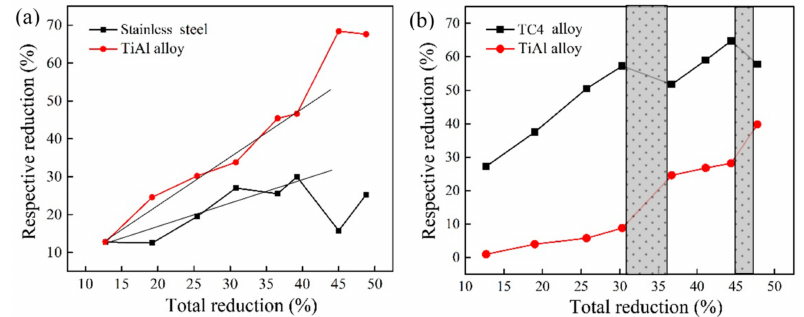
Figure 2. Respective reductions of the packaging materials and TiAl matrix during the compression process of the sandwich structure: ( a ) stainless steel package, ( b ) TC4 alloy package.